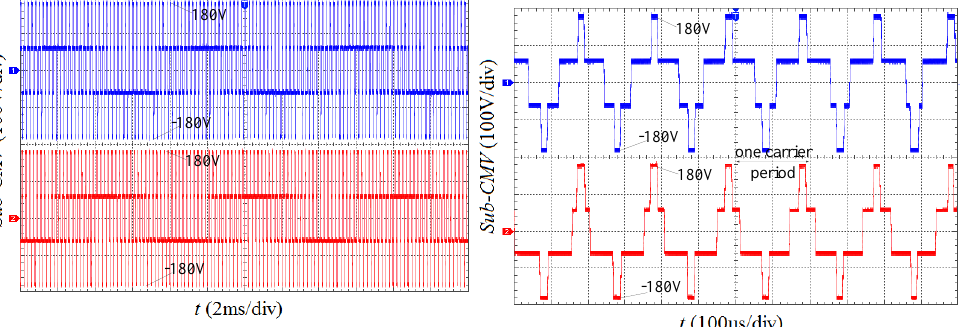
Figure 20. Experimental results of sub-CMVs for DZIPWM. (Blue line denotes the V cm 1 and red line denotes V cm 2 ).